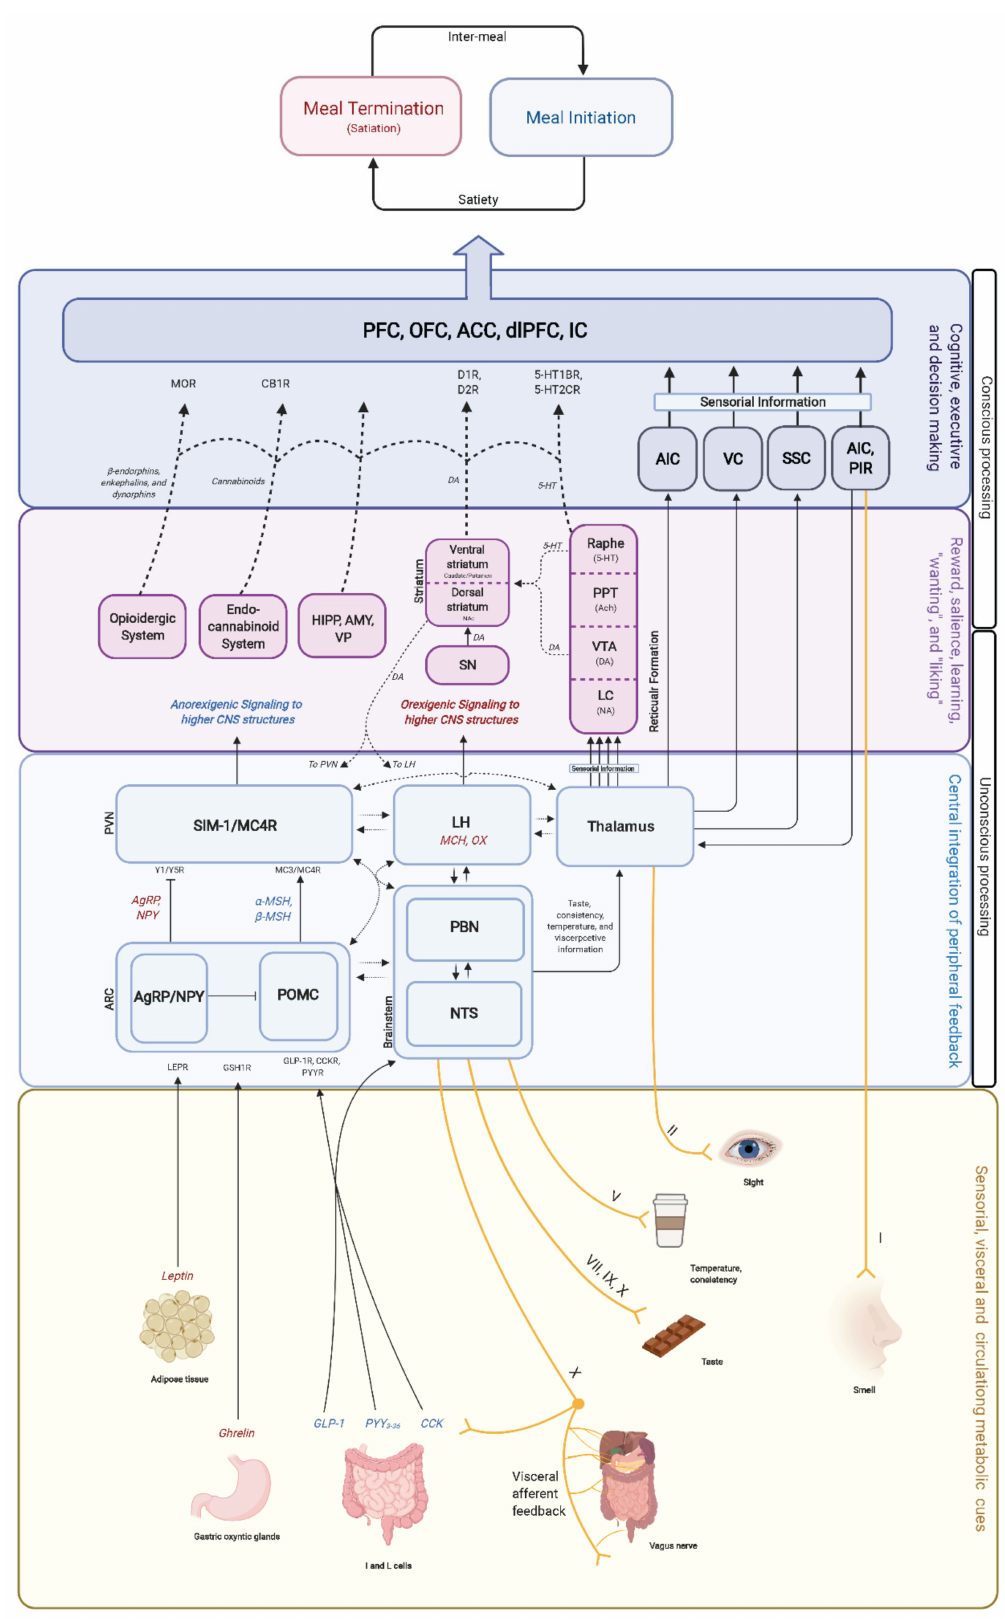
Figure 4. Food intake is regulated by internal and external stimuli perceived through conscious and unconscious pathways in a multi-level fashion. Internal and external signals (yellow